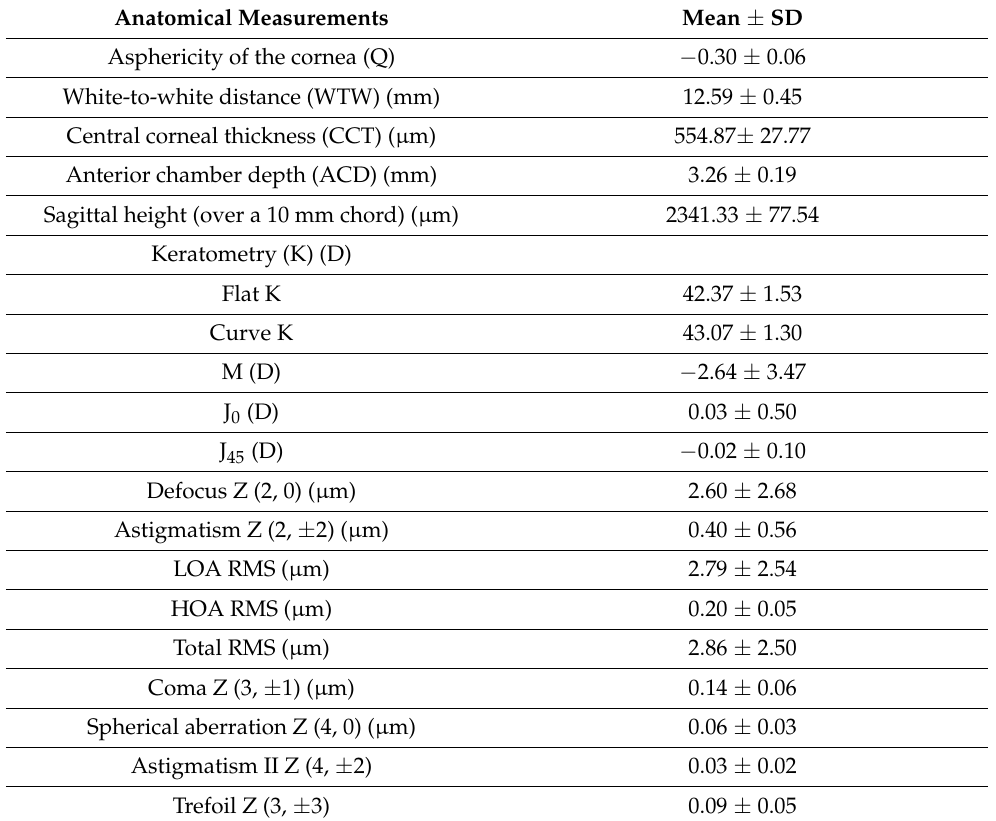
Table 1. Summary of the anatomical, refractive and ocular aberrometric measurements before lens wear in the sample evaluated.